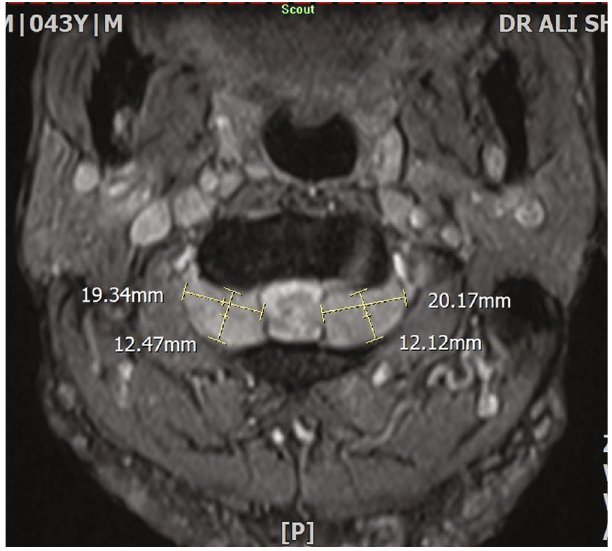
Figure 2: Bilateral symmetrical C2 GN- axial T2WI at